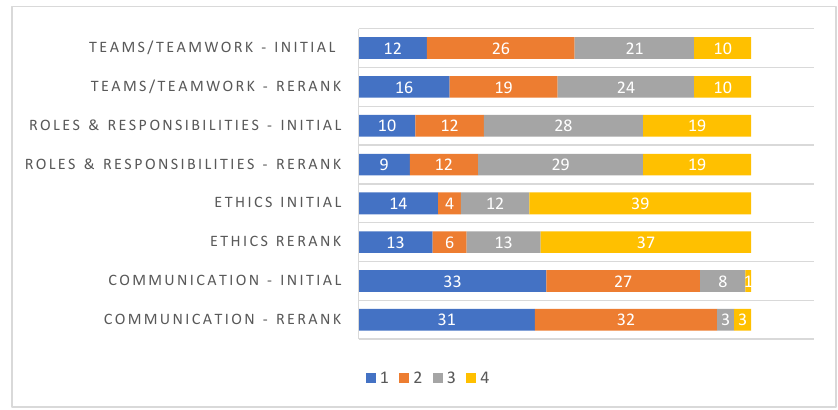
Figure 1. Ranking & re-ranking of IPEC competency. (1 = most important, 4 = least important).